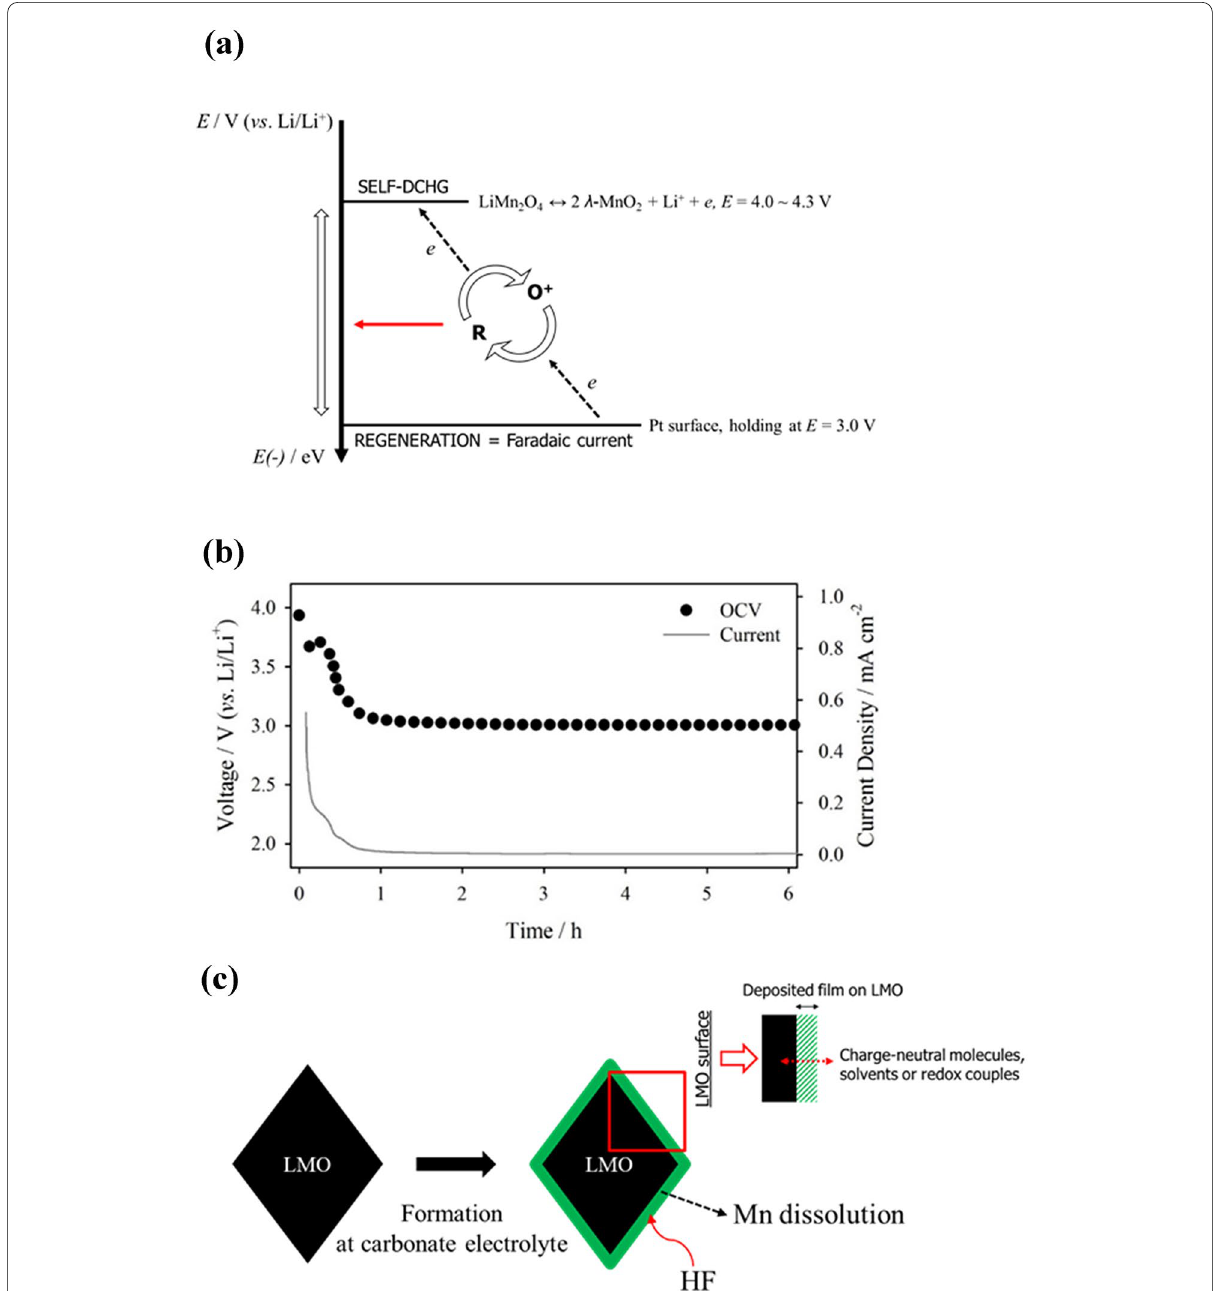
Fig. 4 a Potential diagram of electrochemical response. b Time vs . OCV plot from Li/Pt/LMO/Li four electrode cell and time vs . current density recorded at 3.0 V ( vs . Li/Li + ) polarized Pt mesh electrode. c Schematic diagram of the results observed by redox‑indicator